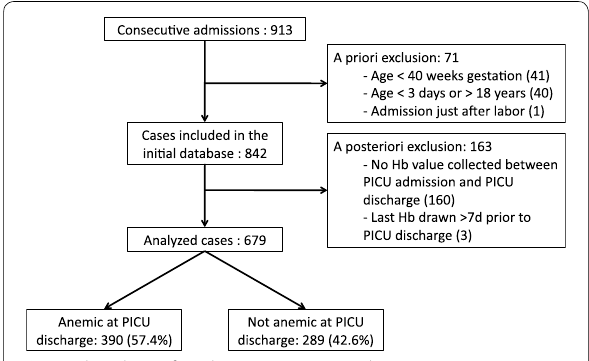
Fig. 1 Flowchart of study patients. PICU pediatric intensive care